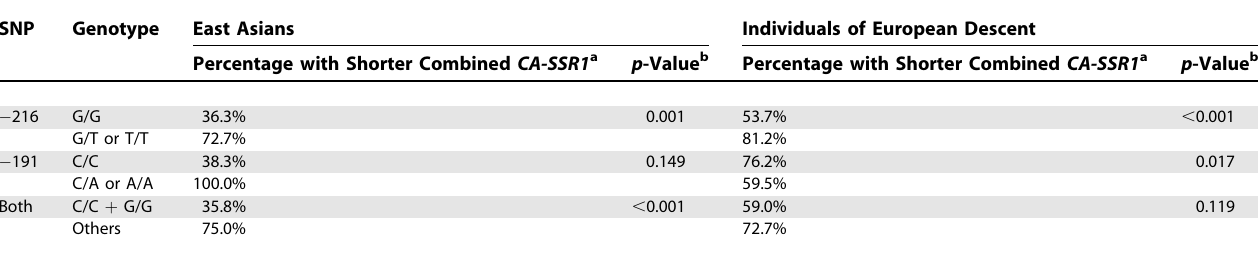
Table 6. Ethnic Differences in the Relationship between the Length of CA-SSR1 and SNPs (cid:2) 191 and (cid:2) 216 SNP